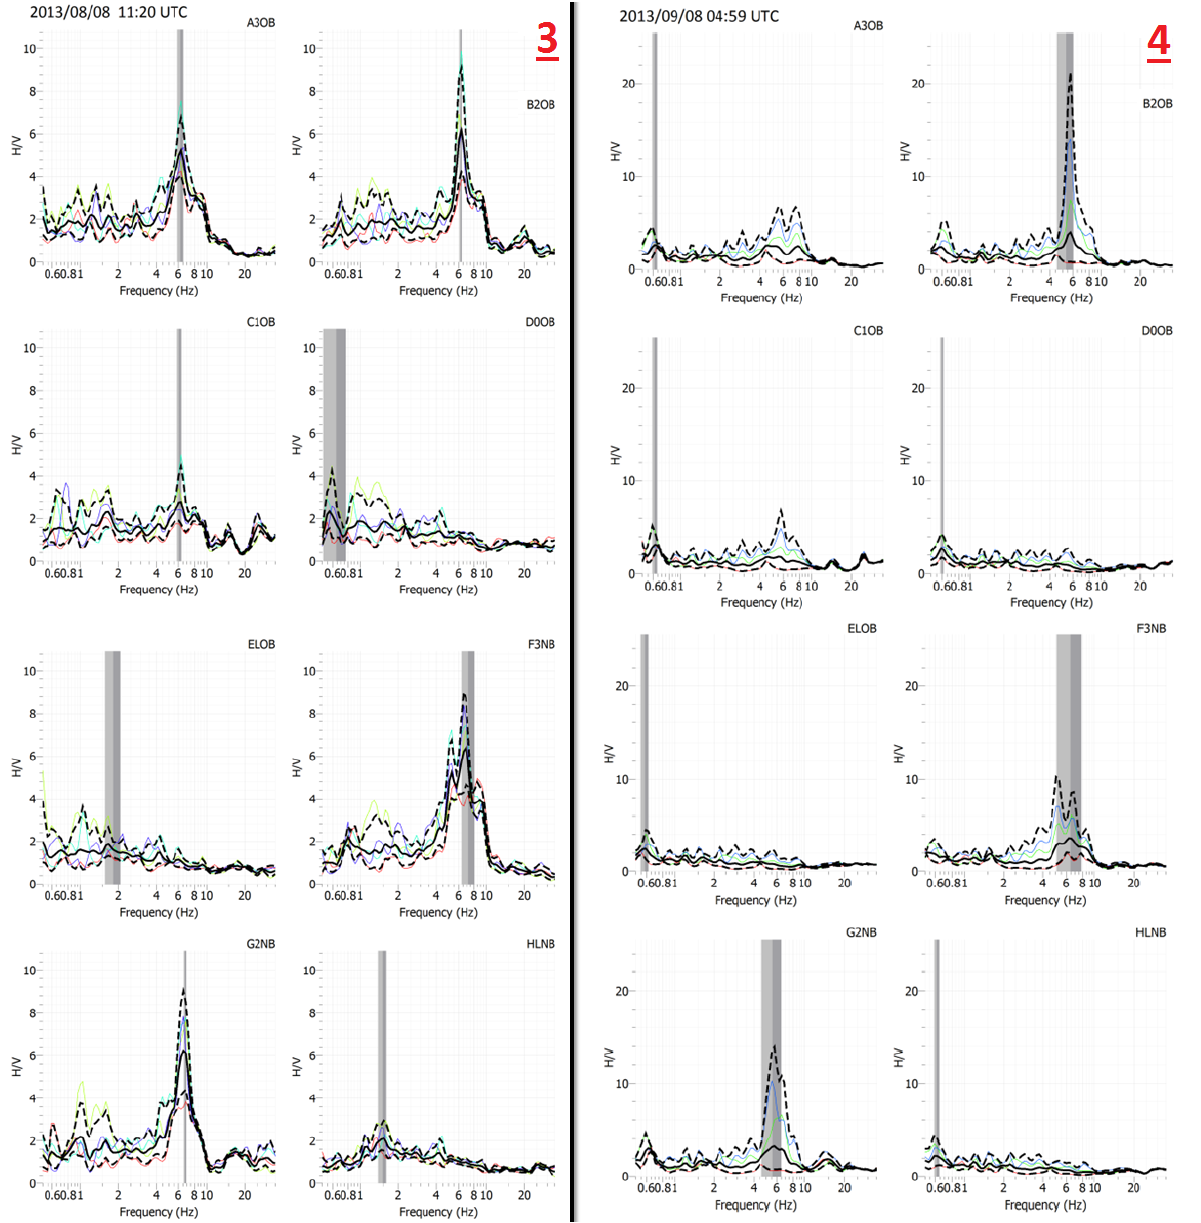
Figure 14. HVSR analysis of seismic events with code names 3 (left) and 4 (right).